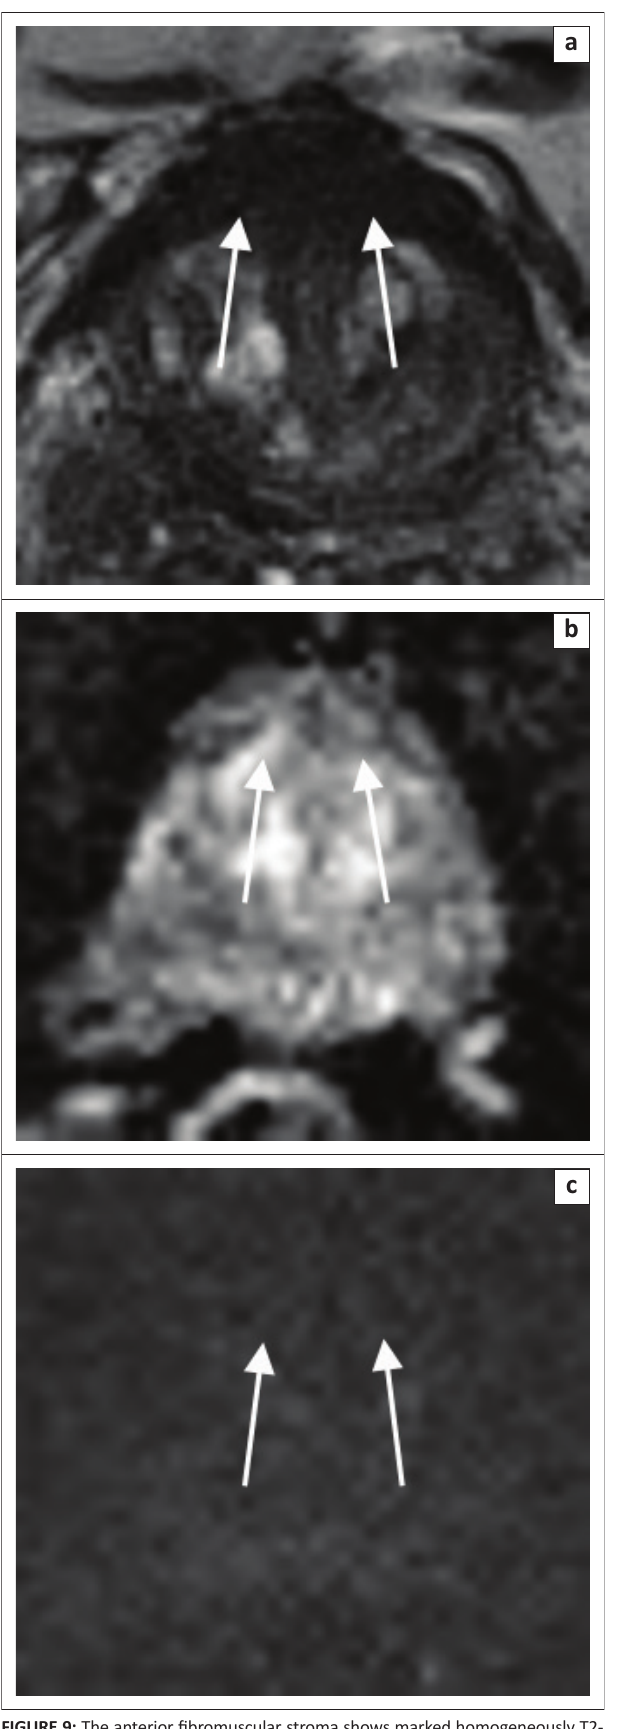
FIGURE 10: Sample reporting template devised using multiparametric prostate magnetic resonance imaging.